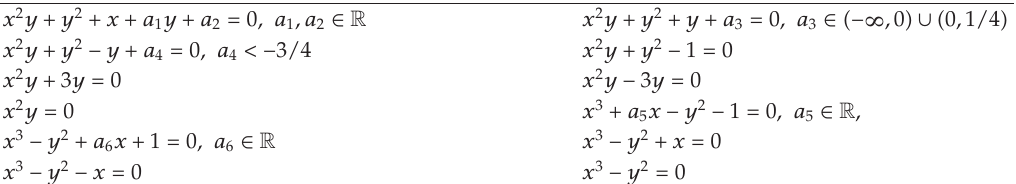
Table 3: Real Hessian polynomials.